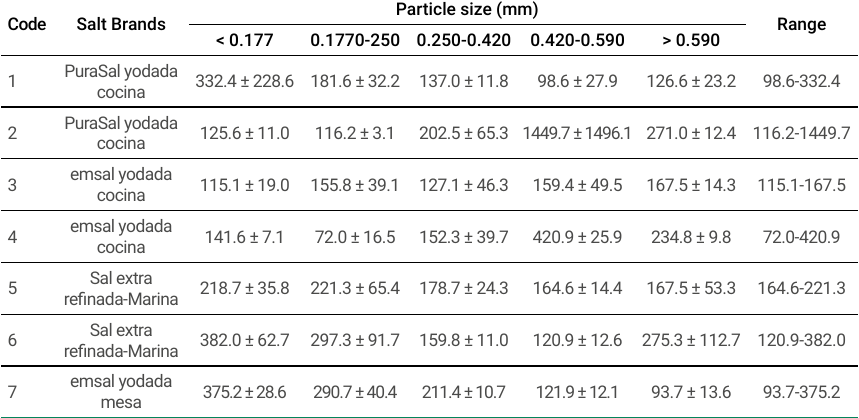
Table 3. Mean (± SD; n=3) of fluoride concentration (mg F/kg) found in the fractions of the salt samples and the range found Code